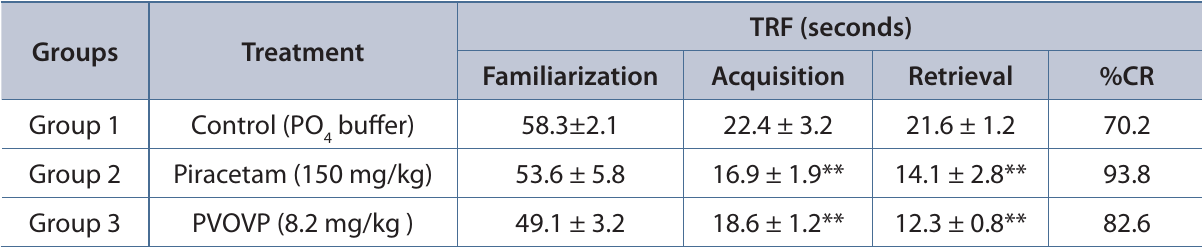
Table 1. Effect of photooxidized Vespa orientalis venom protein on memory and learning in T-maze